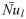
Comparison between the evaluated average Nusselt number Nu¯l in the present study and those reported by Costa [20].